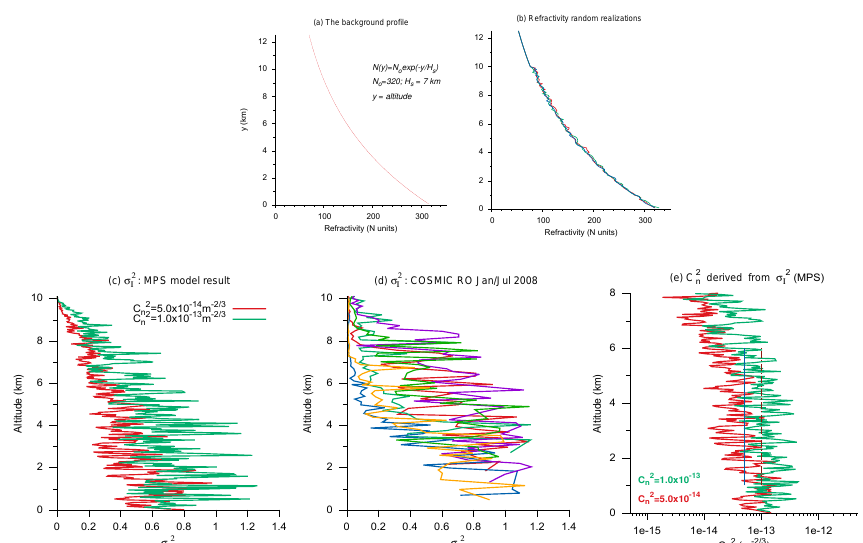
Figure 5. (a, b) Example refractivity profile employed as an input for the multi phase screen (MPS) simulation runs; (c) scintillation index σ 2 profiles inferred from MPS model runs; (d) σ 2 I and Arctic, north of Alaska); and (e) C 2 n derived from σ 2